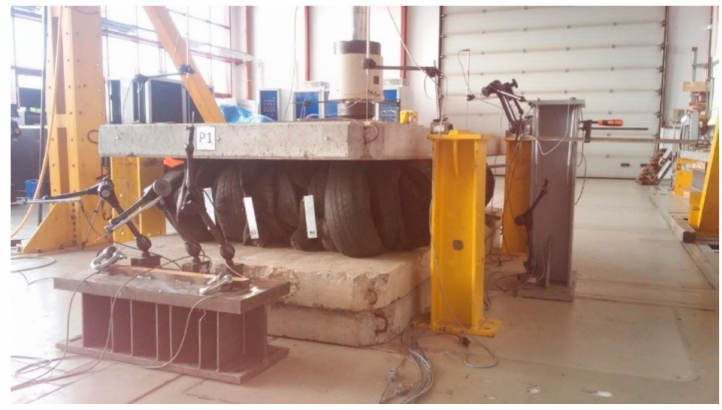
Figure 4. Compression test